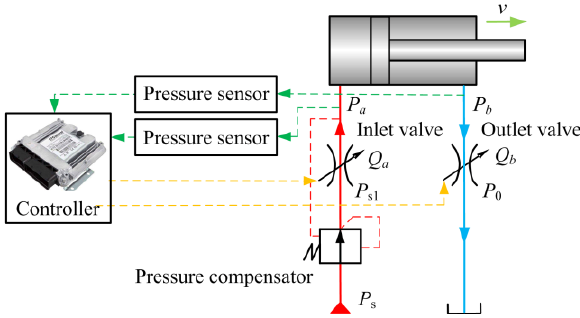
Figure 5. Hydromechanical pressure compensation method.